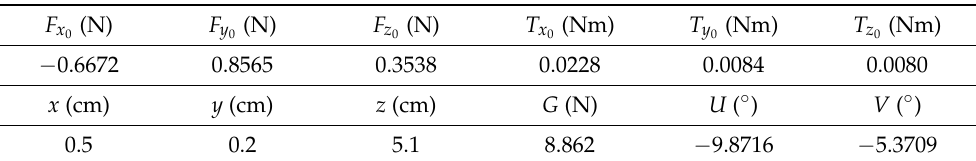
Table 2. Identification